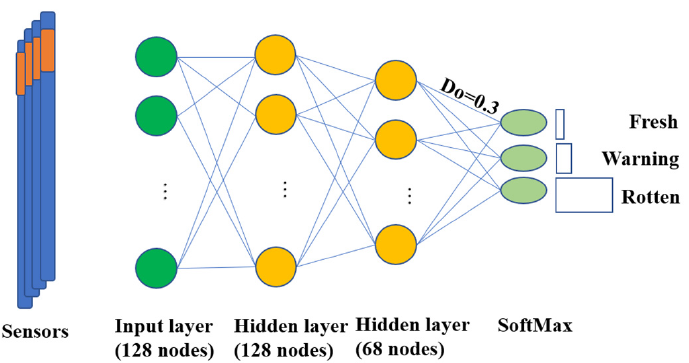
Figure 13. Structure of the Vanilla MLP model.